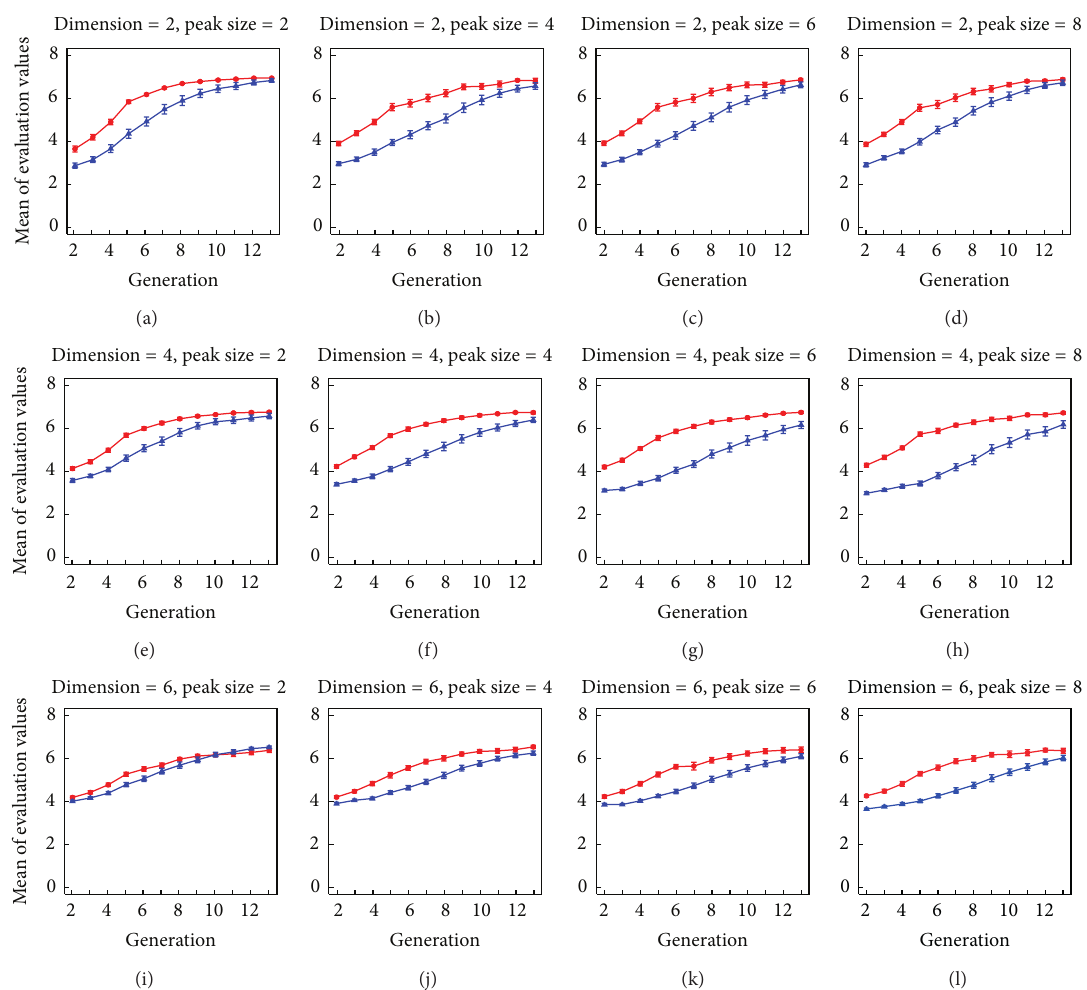
Figure 11: Mean of the evaluation values of population in each generation. The horizontal axis represents the generations and the vertical axis is the mean of the evaluation values of population after 100 trials. The bar represents the standard error. The results of the proposed method are depicted by the solid red lines and those of the conventional method by the dotted blue lines. The graphs in the same row correspond to landscapes of equal dimensions and those in the same column correspond to landscapes with the same number of